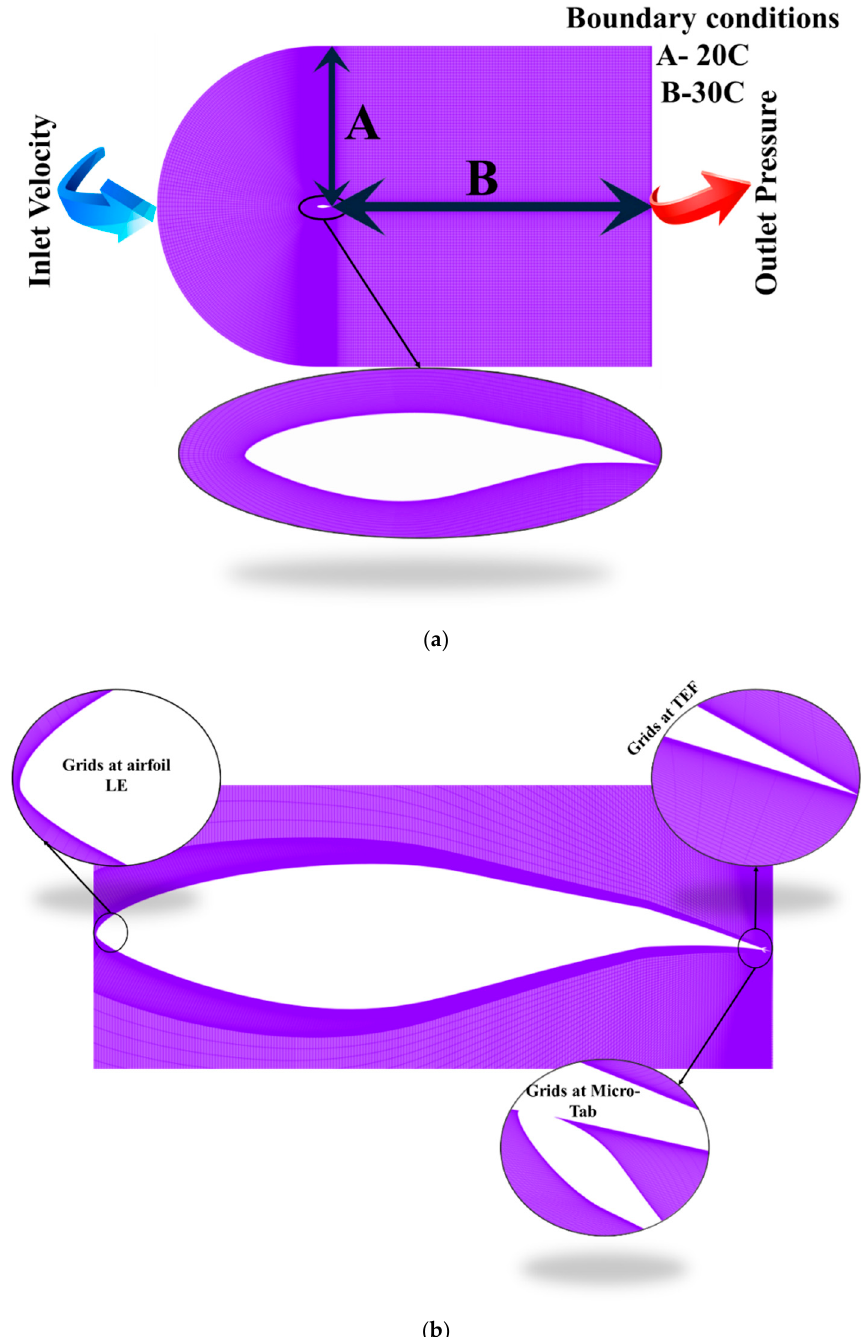
Figure 4. Detail of the grid structure of the airfoil: ( a ) boundary conditions and mesh domain on the airfoil S-809 with TEF; ( b ) mesh domain of TEF with Micro-Tab pattern 3.